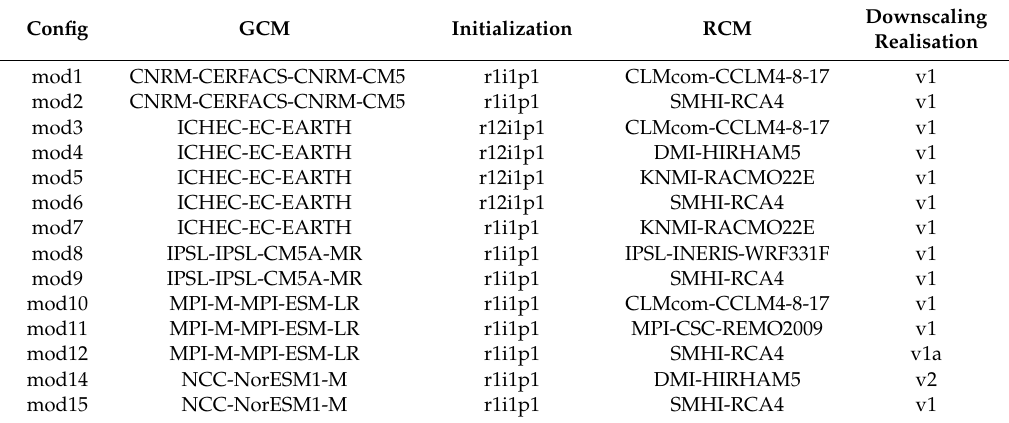
Table 1. Forcing Global Model (GCM) and Regional Model